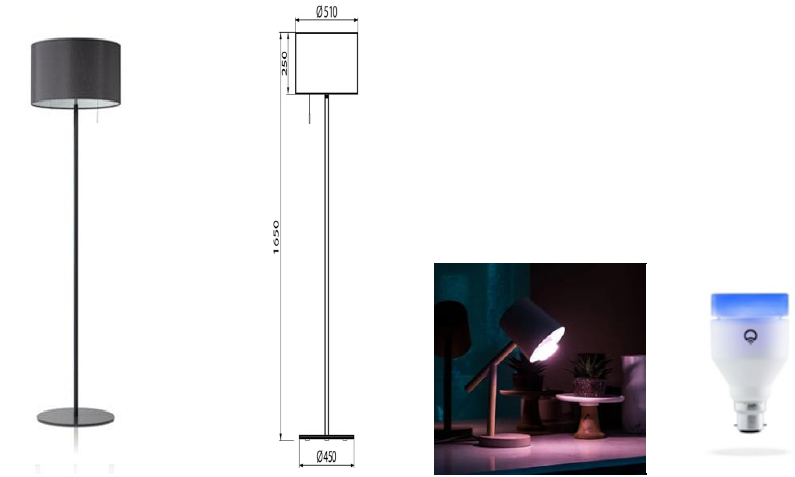
Figure 1. The used lighting system: ( left ) Waldmann VTL-lamp; ( right ) LIFX dynamic light bulb. Table 2. Estimated illuminance and equivalent daylight (D65) illuminance (EDI) based on the task/lap and eye levels of the free-floor standing luminaire.